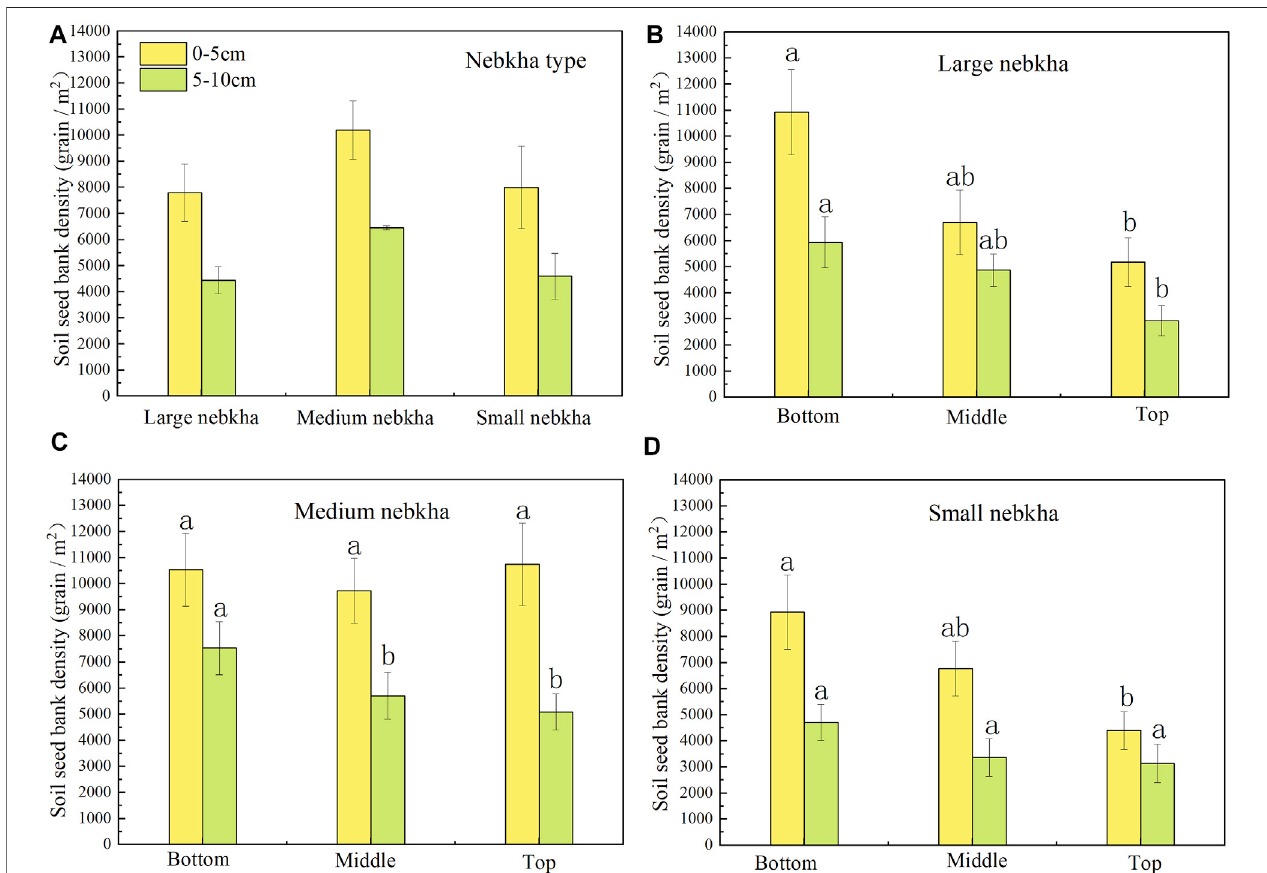
FIGURE 4 | Soil seed bank density at different soil depths. The letters in the fi gure indicate signi fi cant differences (p < 0.05). (A) Comparison of soil seed bank densityinlarge,mediumandsmallnebkha. (B – D) Comparisonofsoilseedbankdensityatthetop,middleandbottomofthelarge,mediumandsmallnebkhaatdifferent soil depths.